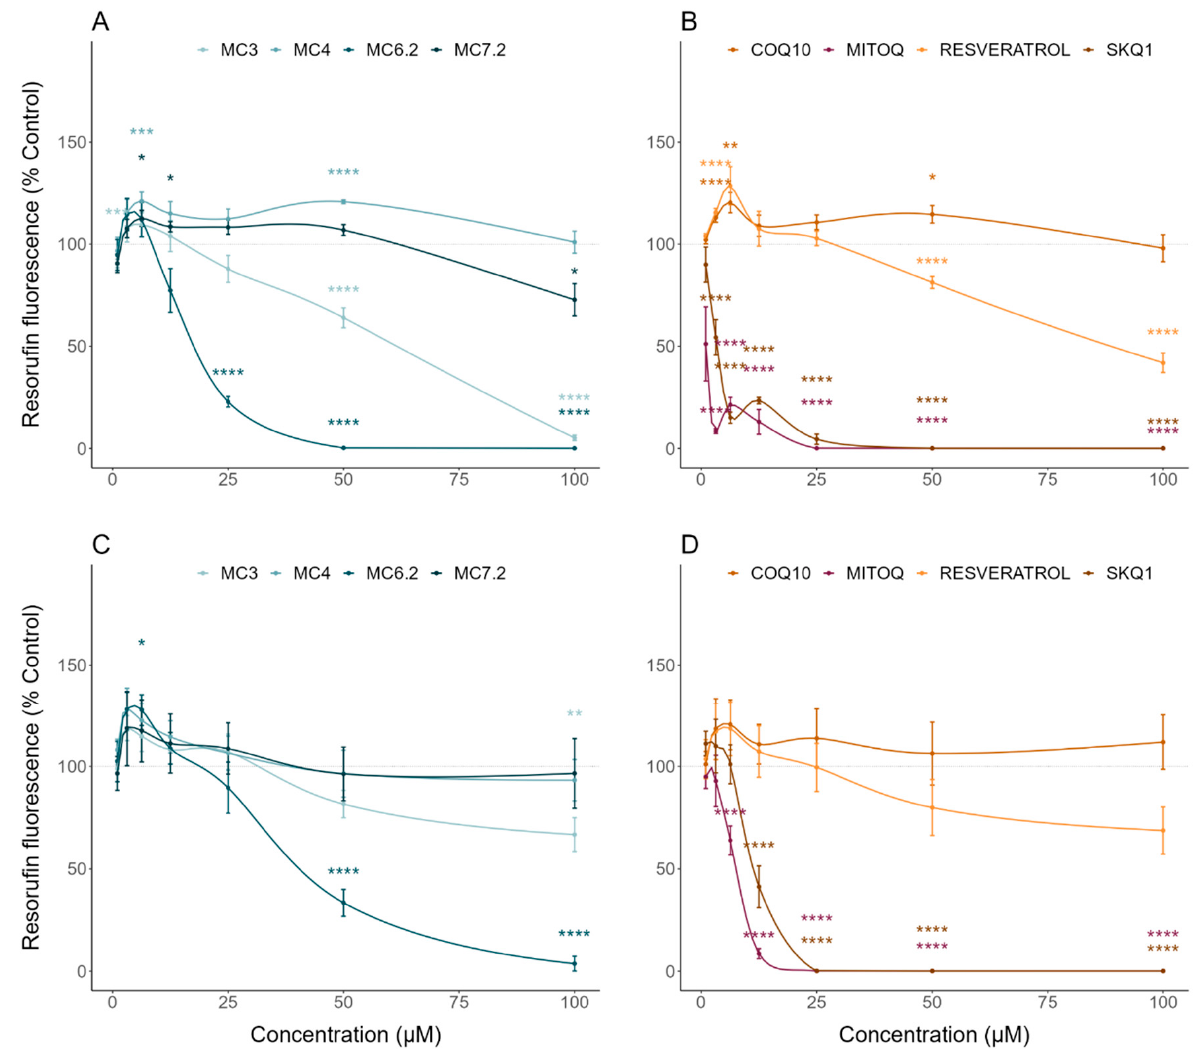
Figure 3. Effect of MitoCINs, quinone-based mitochondria-targeted and non-targeted antioxidants on metabolic activity. Human Caucasian hepatocyte carcinoma (HepG2, ( A , B )) and differentiated human neuroblastoma (SH-SY5Y, ( C , D )) were treated with increasing concentrations of the different molecules for a period of 48 h and metabolic activity was evaluated using resazurin reduction assay. Data are the mean ± SE of four independent experiments and the results are expressed as a percentage of the control (control = 100%). Statistically significant differences between control (CTL) and treated groups were evaluated using a t -test. **** p < 0.0001, *** p < 0.001, ** p < 0.01 and * p < 0.05 compared to the respective control (CTL).